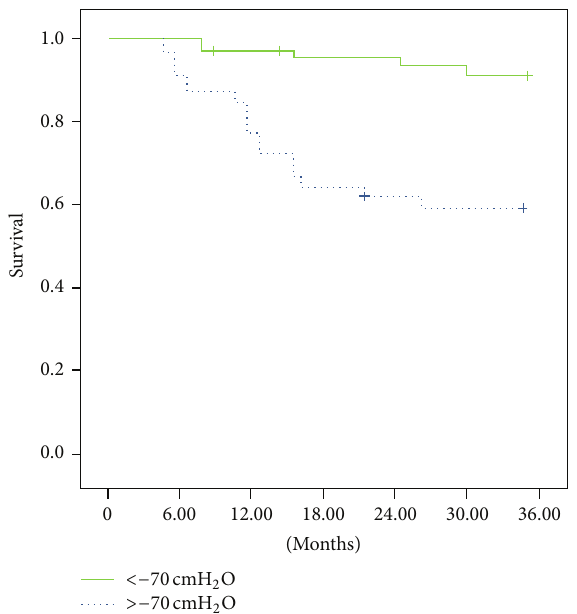
Figure 2: Individuals with pressure below − 70 cmH 2 O had a survival rate of 62% compared with a rate of 93% for those with pressure above − 70cmH 2 O ( 𝑝 = 0.0001 ); relative risk = 2.25 (1.3– 5.21, 95% CI).